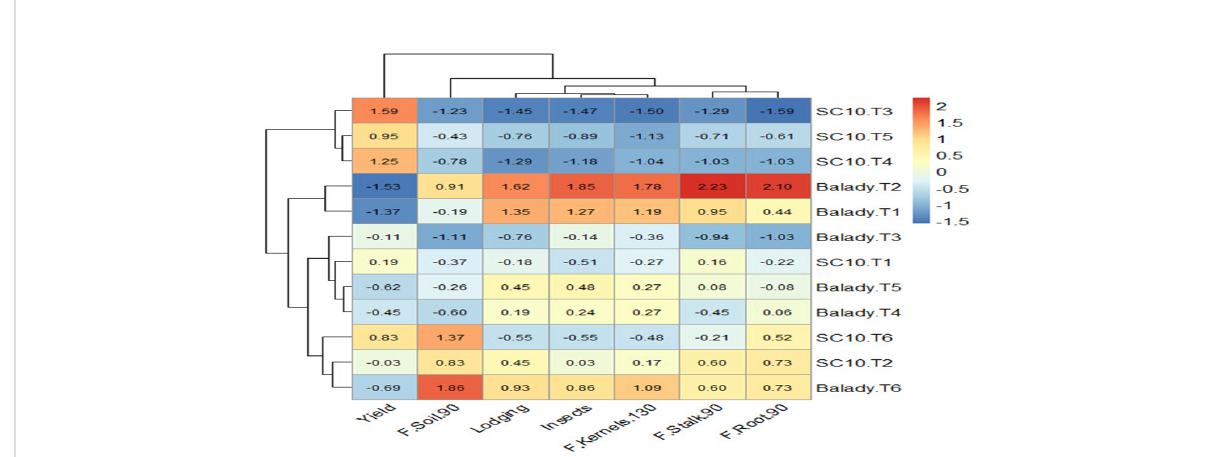
FIGURE 7 Heatmap showing the relationship between the studied traits and the treatments.